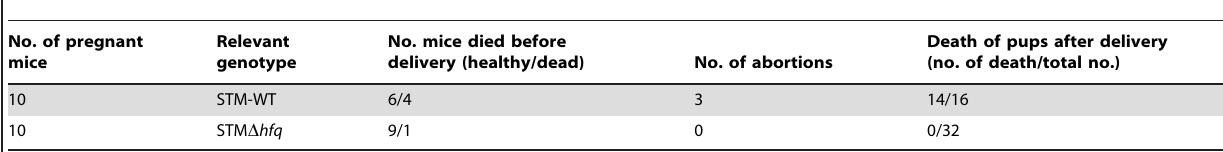
Table 1. Safety of the STM D hfq vaccine strain in pregnant mice.